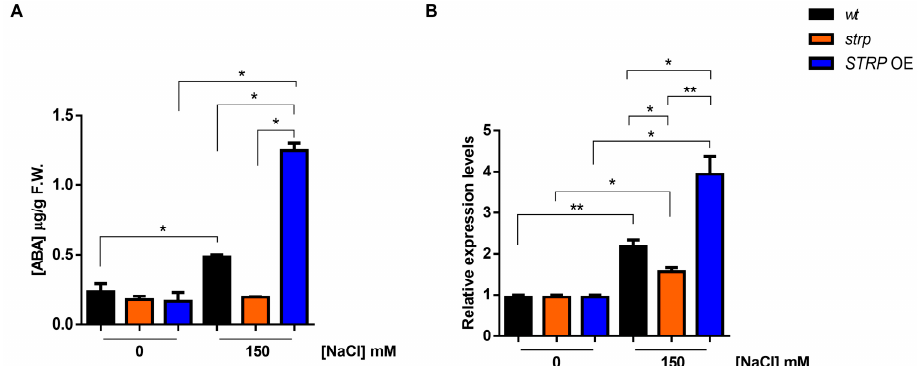
Figure 5. Effect of salt stress on ABA content and NCED3 expression in wt, strp, and STRP OE plants under salt stress. ( A ) HPLC determination of abscisic acid (ABA) content in two-week-old A. thaliana wt , strp, and STRP OE plants treated with 150 mM NaCl for 18 h. ( B ) The 9-cis-epoxycarotenoid dioxygenase ( NCED3 ) expression was assessed on total RNA extracted from A. thaliana wt , strp, and STRP OE plants treated with 150 mM NaCl for 18 h by RT-qPCR. Error bars are s.e.m. of three independent experiments. * p < 0.05, ** p < 0.01, by Student’s t -test.